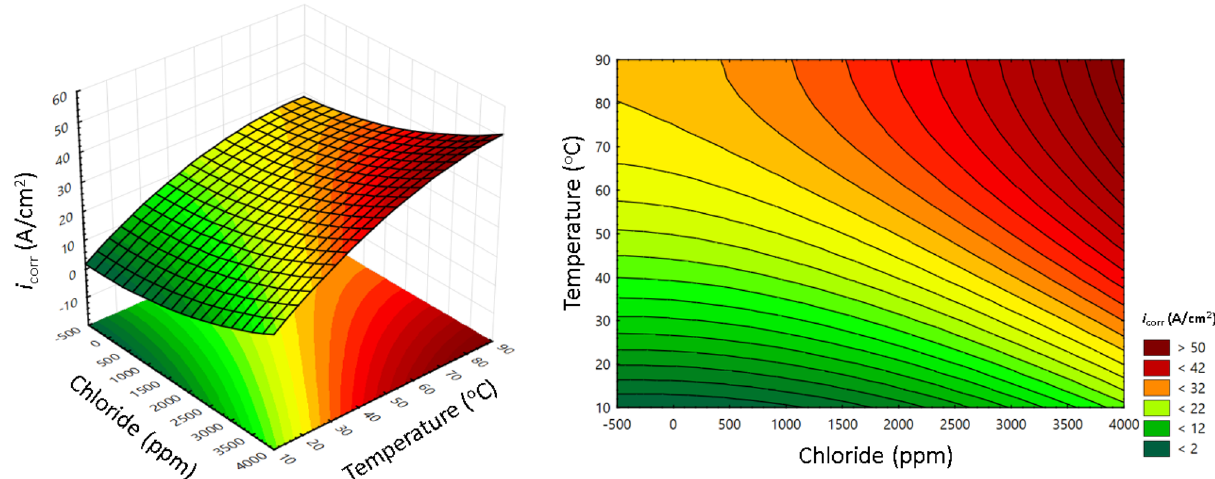
Figure 17. Influence of two major factors (temperature, chloride) on the corrosion rate of carbon steel in